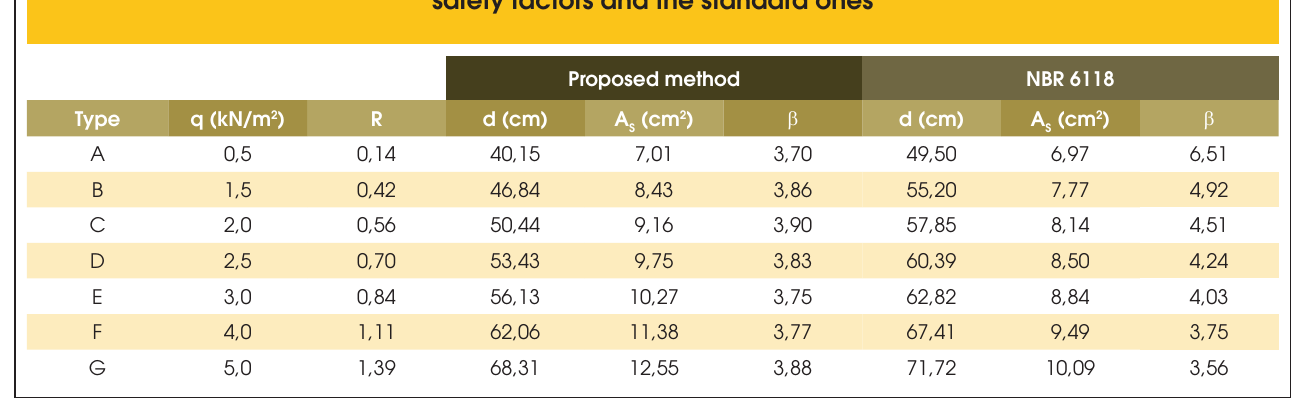
Table 4 – Design of the beams considering the set of calibrated safety factors and the standard